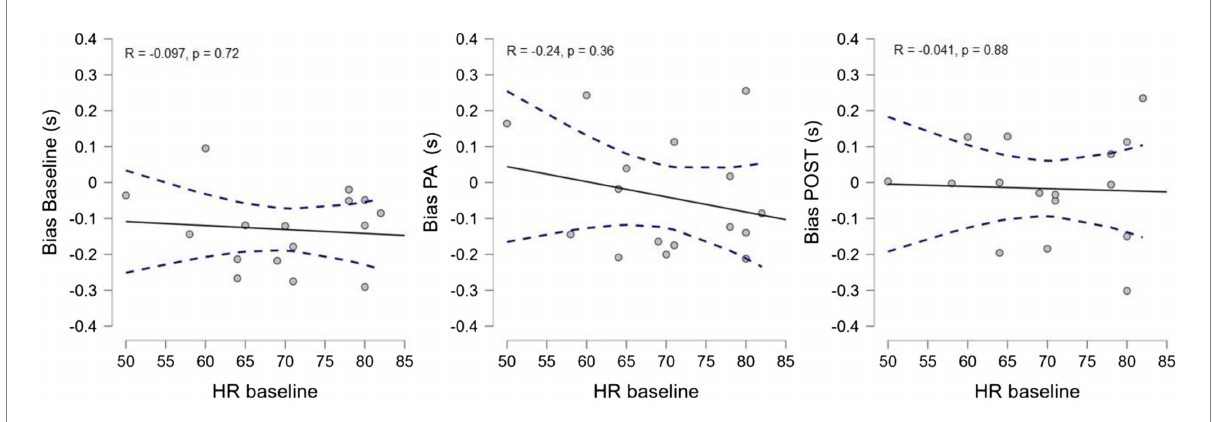
FIGURE 5 Correlation between the average HR in the baseline condition and the average temporal bias for each experimental